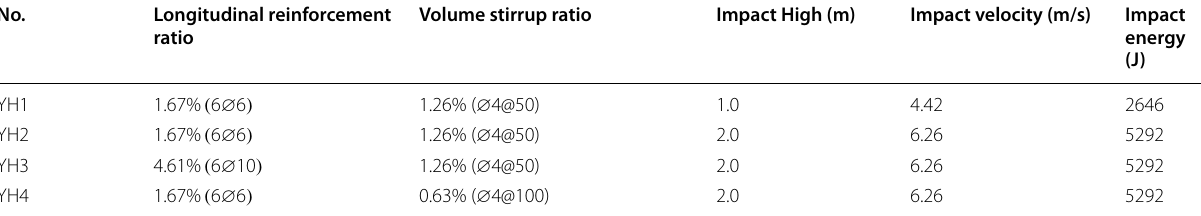
Table 1 List of sample